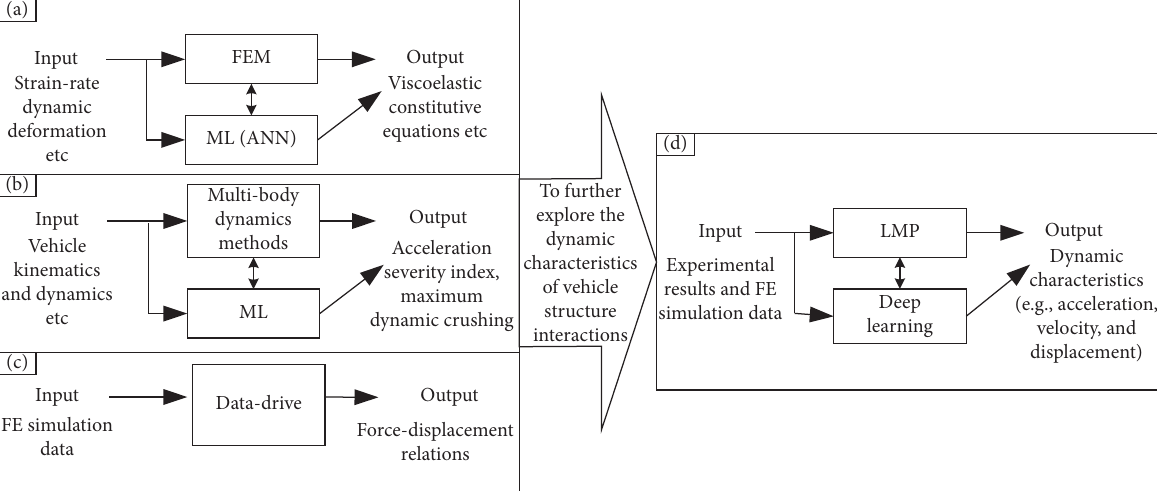
Figure 1: Mechanistic and statistical methods for mechanics